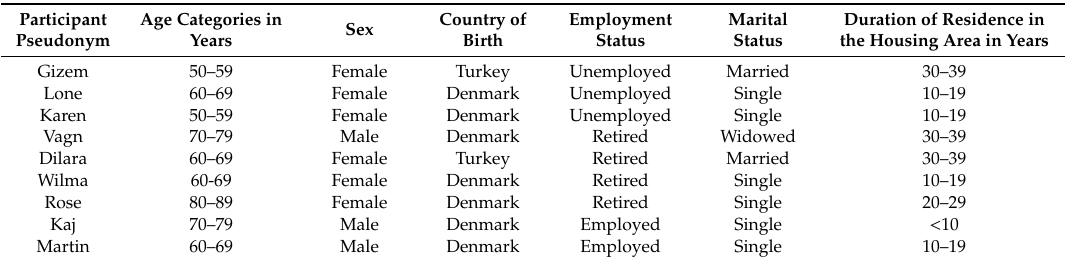
Table 1. Participant